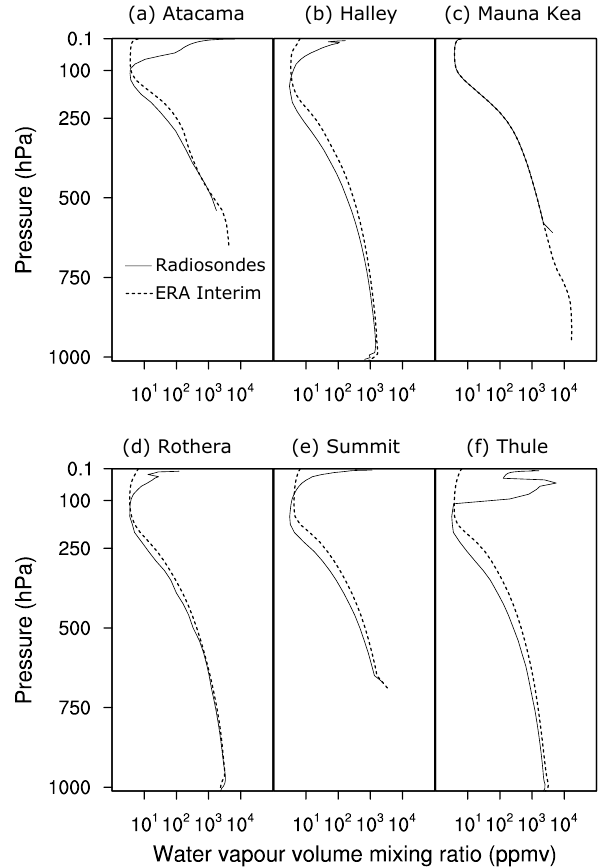
Figure 3. Climatologies of water vapour volume mixing ratio for radiosonde measurements (solid line) and ERA-Interim reanalysis data (dashed line) at all six sites (a–f) . Radiosonde profiles are the average of all data available at each site. ERA-Interim data are sub- sampled to retain only the days when radiosondes were